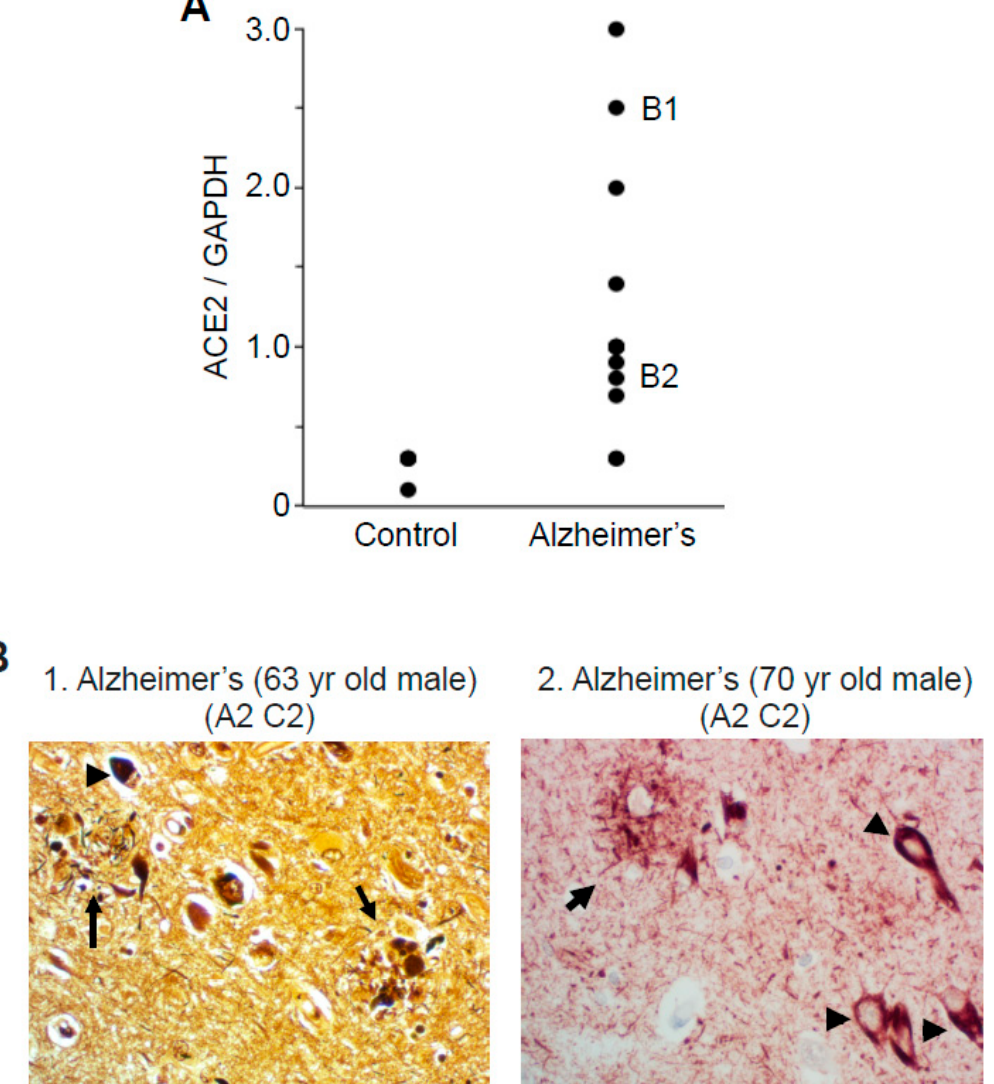
Figure 2. Variations within groups for results of ACE2 expression and histological evaluations of patients with Alzheimer’s disease. ( A ) Brain (hippocampus) homogenates from control subjects and patients with Alzheimer’s disease were investigated by Western blotting using antibodies against ACE2 and GAPDH. The dot graph represents values of the ratio of ACE2 to GAPDH for each control subject and patients with Alzheimer’s disease. Panel numbers of patients whose histology results are shown in Panel B are indicated in the graph. ( B ) Formalin-fixed, paraffin-embedded hippocampus tissues from patients with Alzheimer’s disease were cut and subjected to Bielschowsky silver staining (B1) or PHF-1/p-Tau immunohistochemistry (B2). Age, gender, A β plaque score (denoted by the letter A), and neuritic plaque score (denoted by the letter C) are noted for each slide. Brain parenchyma contains lesions such as neuritic plaques characterized by a dark amyloid core (arrows) and neurofibrillary tangles